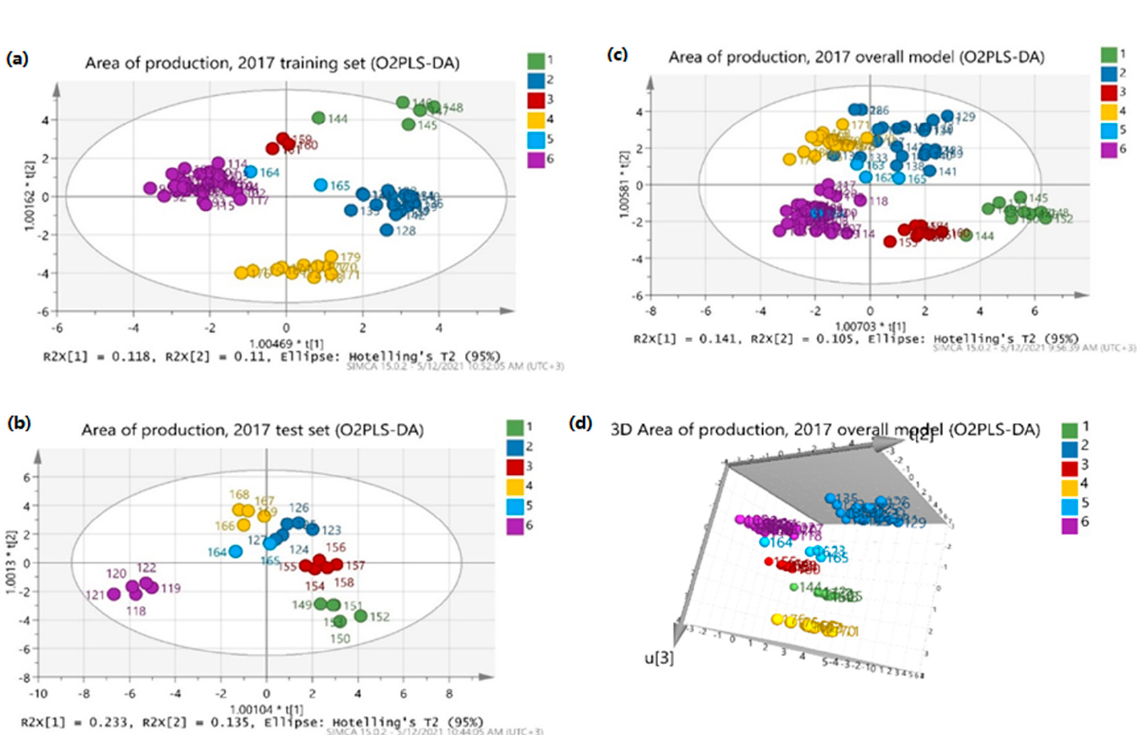
Figure 7. Score scatterplots for the wine samples of 2017 classified regarding area of production (i.e., 1: Naousa, 2: Attika, 3: Nemea, 4: Santorini, 5: Samos, and 6: Arkadia), where ( a ) training set, ( b ) test set, ( c ) overall model 2D, and ( d ) overall model 3D. Table 9. Misclassification tables produced for the O2PLS-DA models of the wine samples of 2018